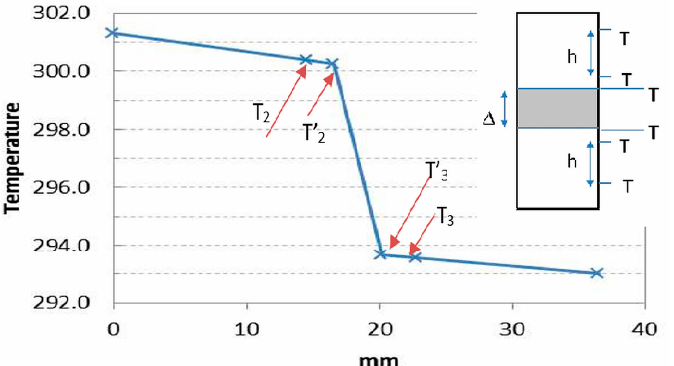
Figure 3. Typical temperature variation across the two samples with TBC at steady state. The temperatures T 2 and T 3 are measured directly with thermocouples, whereas T’ 2 and T’ 3 are extrapolated values.